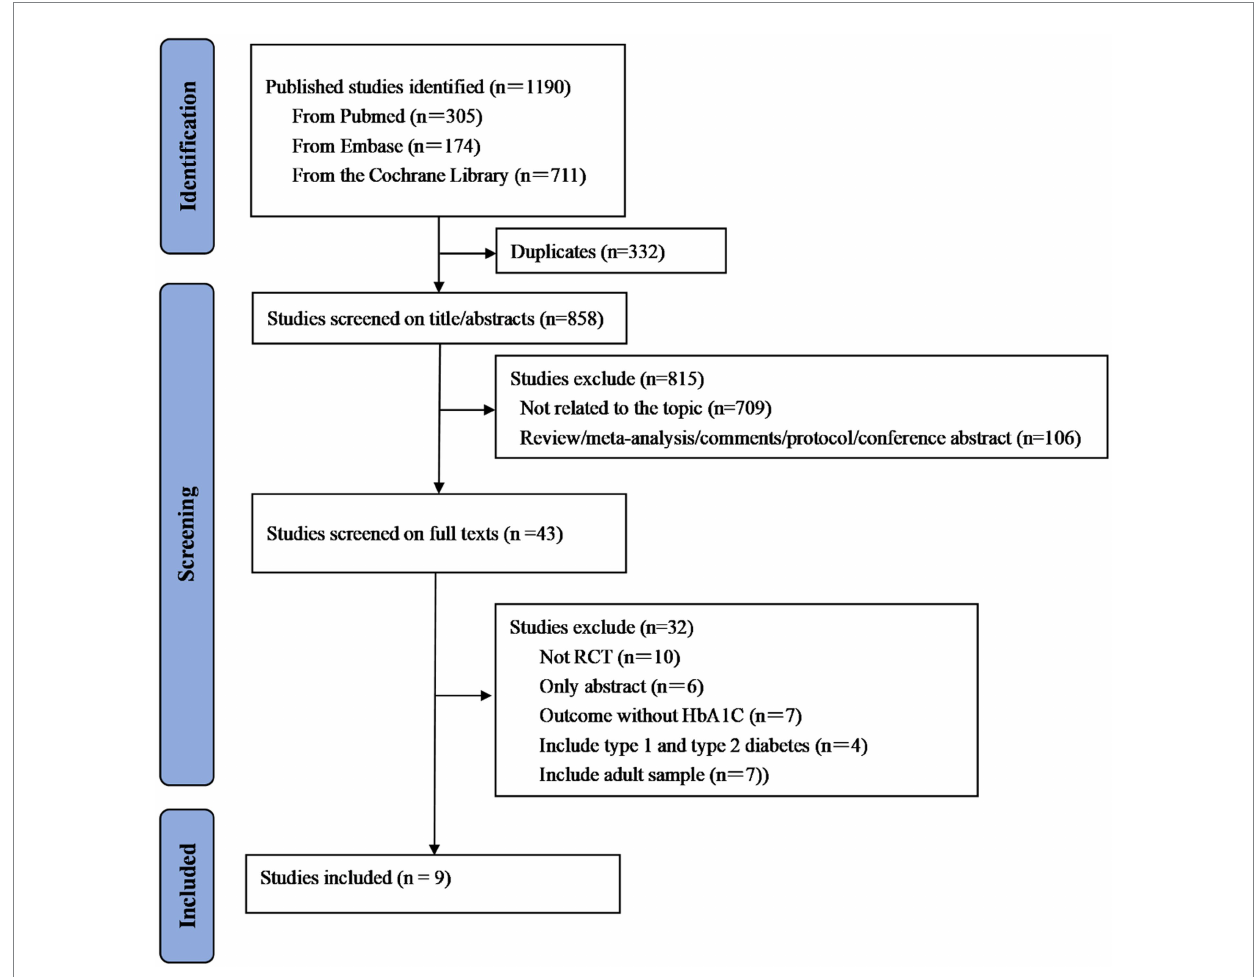
FIGURE 1 PRISMA flow diagram of the study search and